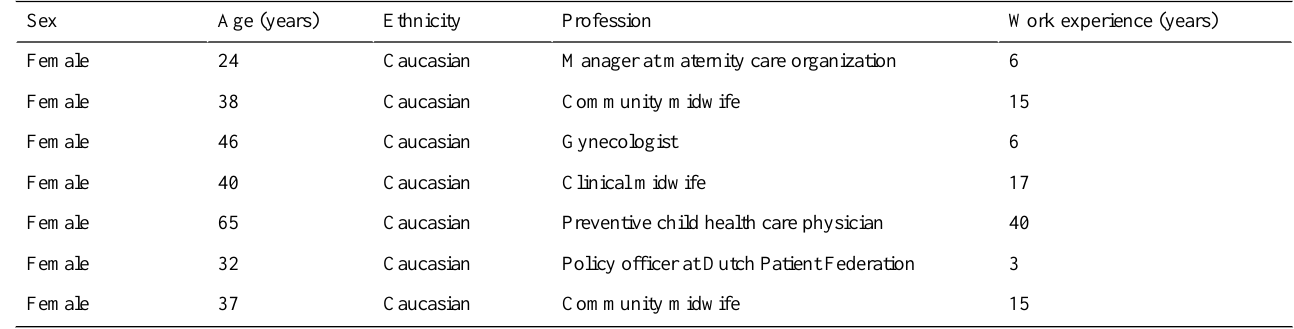
Table 3. Characteristics of participants: clinicians and